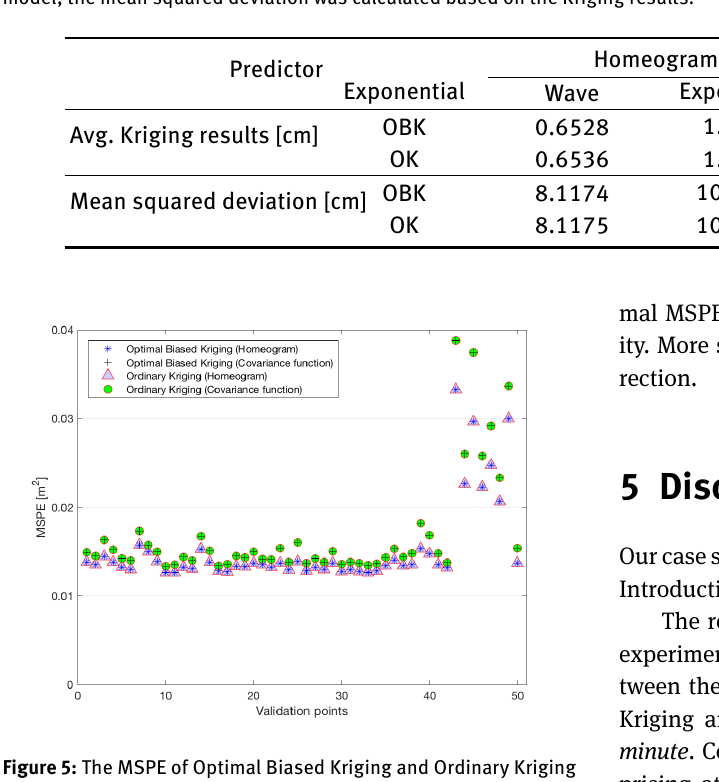
Table 2: Statistics of the Kriging results. The average Kriging results represent the difference between the interpolated value and the geoid model; the mean squared deviation was calculated based on the Kriging results.